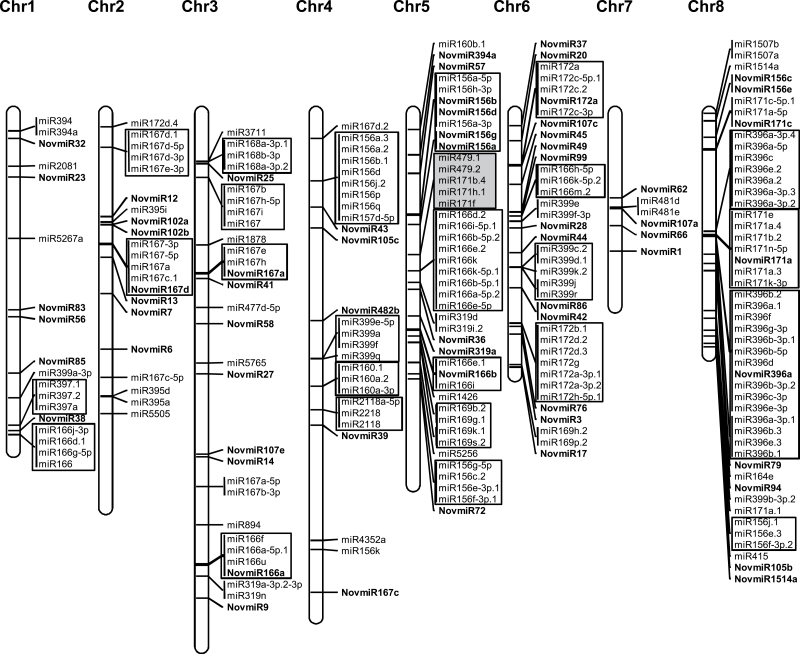
Distribution of miRNAs on eight chickpea chromosomes. The position of each miRNA has been marked. Novel miRNAs are distinguished in bold font. The miRNAs of the same family clustered together are shown in open boxes and miRNAs from different families clustered together in grey box.